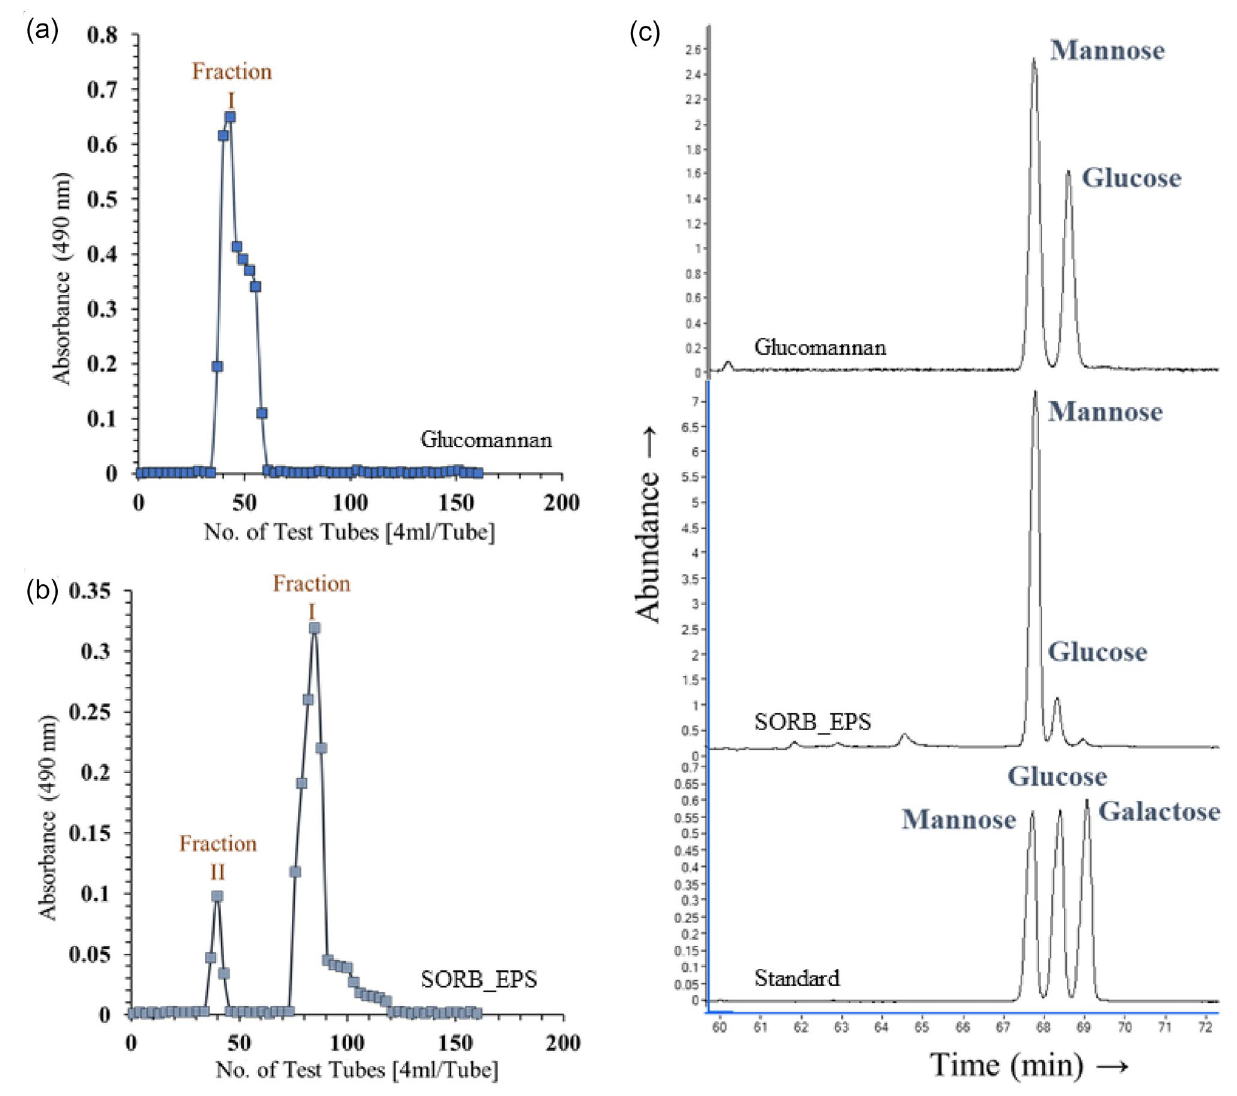
Figure 5. Gel permeation chromatography profile of standard glucomannan ( a ), SORB-EPS ( b ); and GC chromatograms of standard glucomannan, SORB-EPS, standard mannose, glucose, and galactose ( c